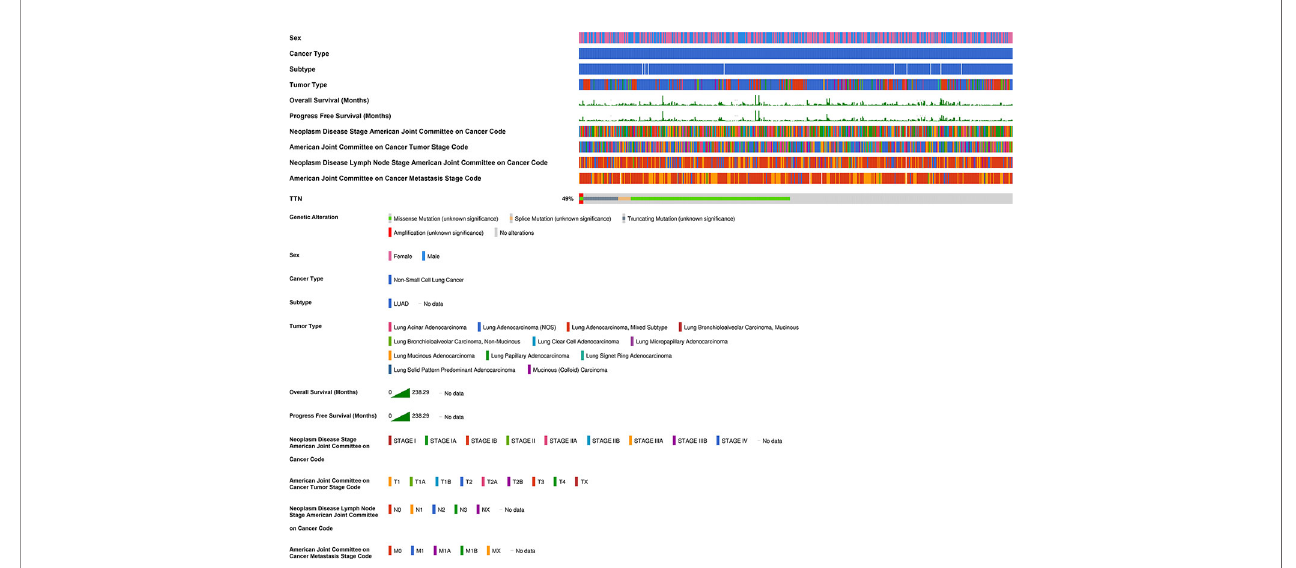
FIGURE 3 | Correlation of TTN mRNA expression with different clinicopathological features in LUAD in the cBioPortal database. The mutation frequency of TTN was 49% in 511 patients with LUAD. 55 patients were excluded from analysis since they were not pro fi led for all queried genes in all queried pro fi les and germline